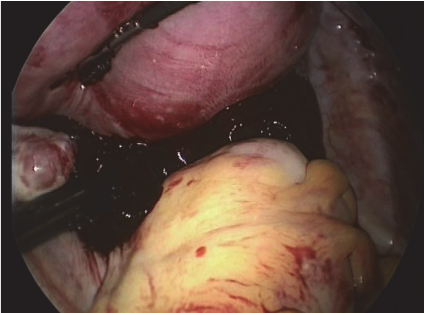
Figure 2: Diagnostic laparoscopy: clot identification in the Douglas pouch.